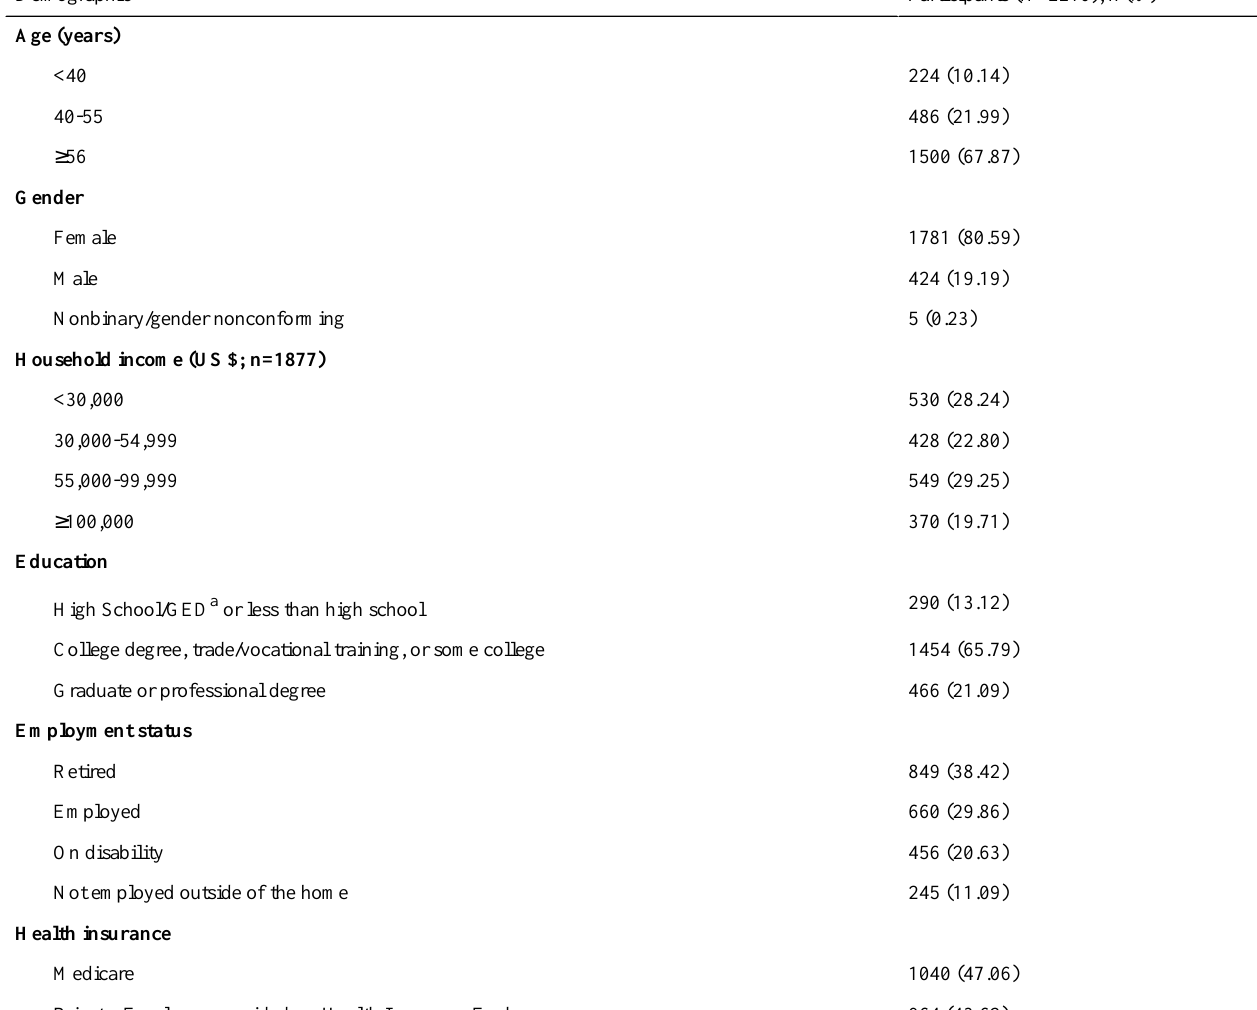
Table 1. Sample demographic and chronic condition